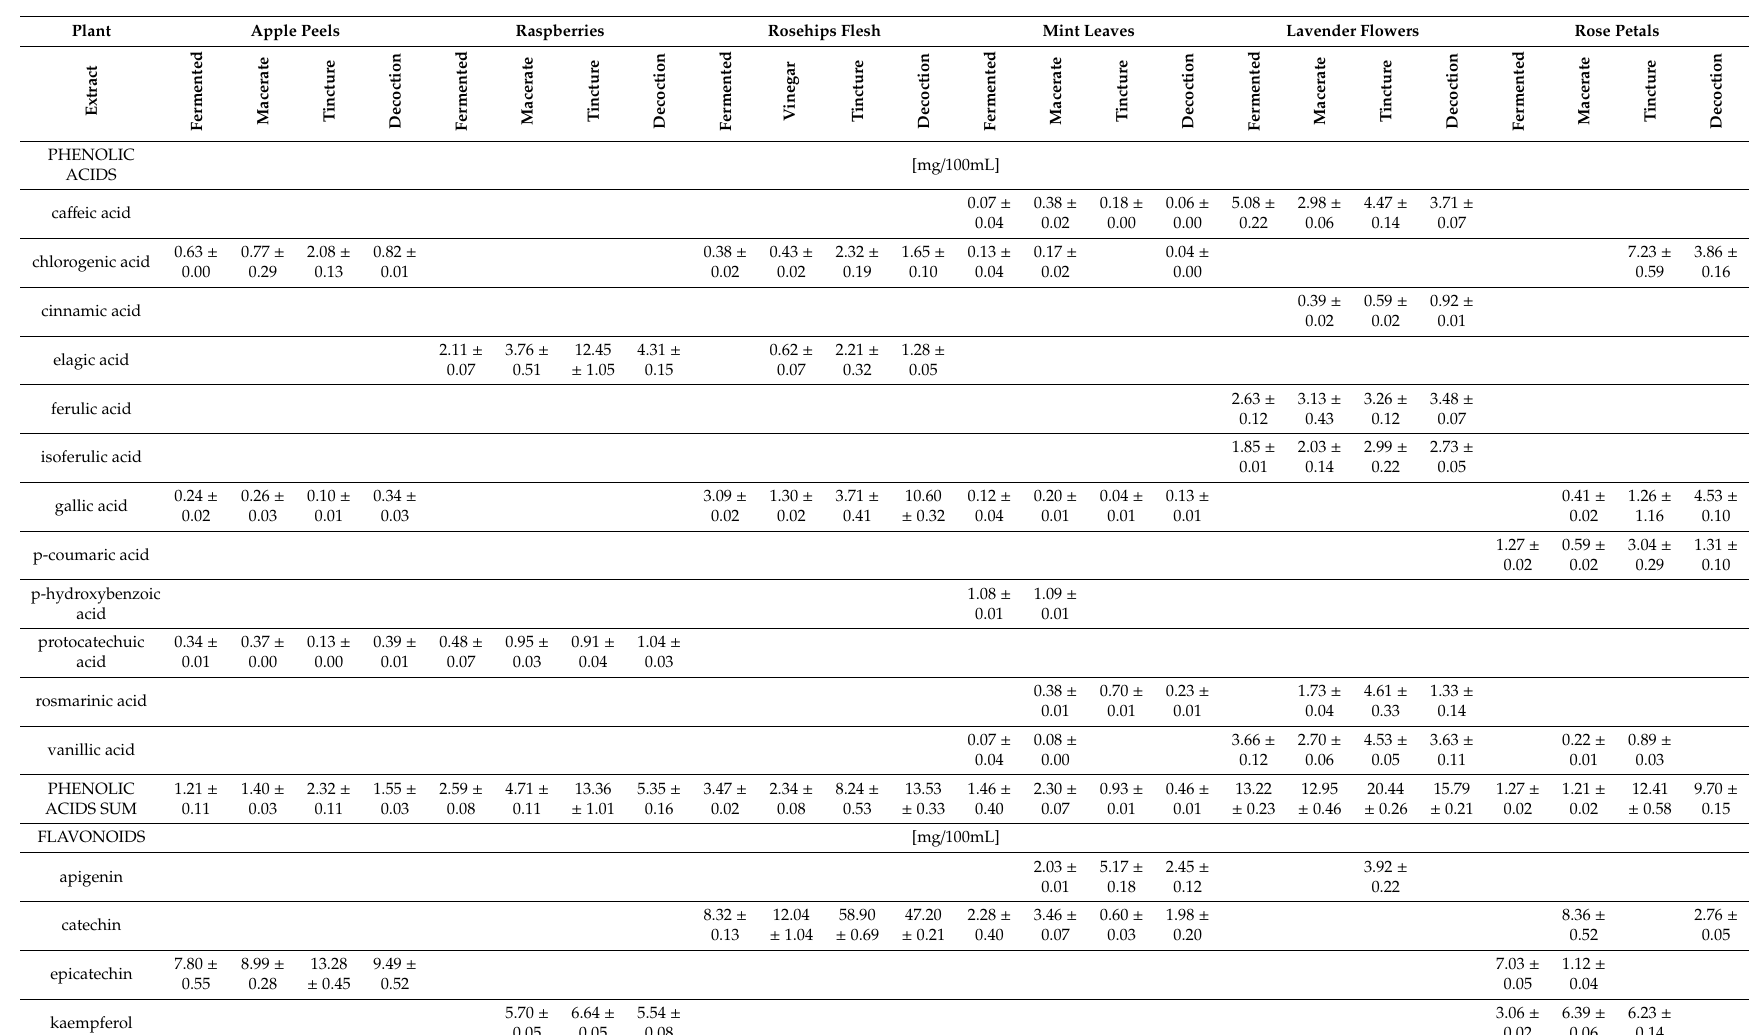
Table 2. Flavonoids and phenolic acids identified in fruit and herb extracts analyzed with